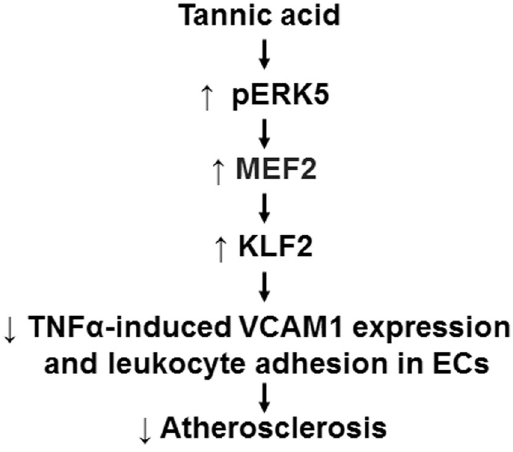
Figure 7. A working model depicting TA-mediated vasoprotective effects via a KLF2-dependent mechanism. Kruppel-like factor 2 (KLF2), tannic acid (TA), myocyte enhancing factor 2 (MEF2), extracellular-signal related kinase 5 (ERK5), phosphorylation (p-ERK5), vascular cell adhesion molecule 1 (VCAM1), endothelial cells (ECs), tumor necrosis factor alpha (TNF α